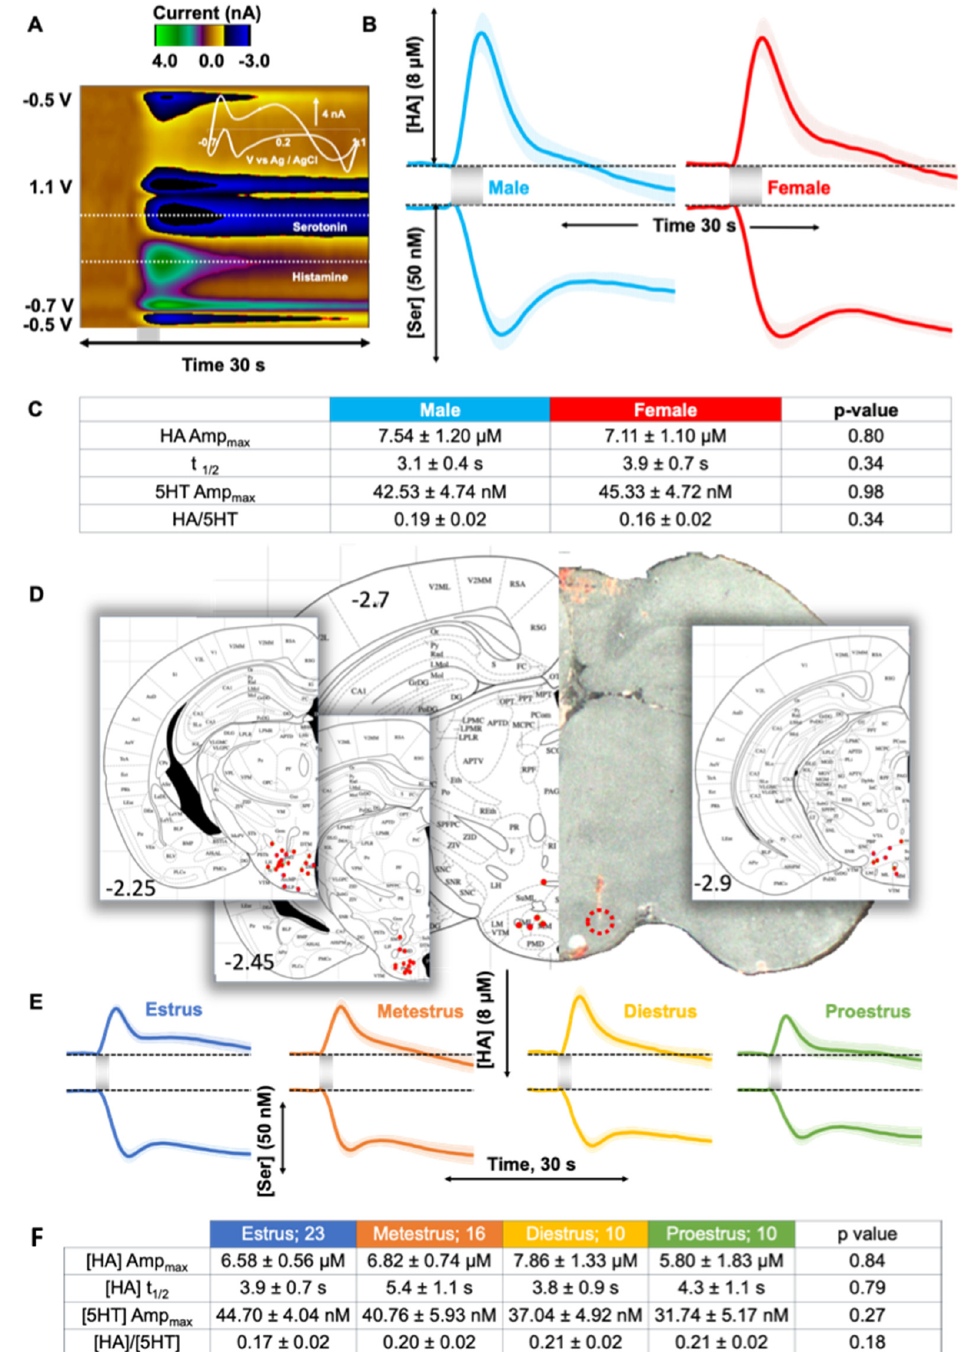
Figure 1. ( A ) Representative color plot of the mouse TMN upon MFB stimulation. Inset in the top right corner is the characteristic CV with peaks occurring around 0.2 V for histamine and 0.7 V for serotonin oxidation. The concentration vs. time traces for the release of histamine and inhibition of serotonin are shown for ( B ) male (blue) and female (red) mice. Electrical stimulation (2 s) is represented by the grey bars. ( C ) Tabulated values of metrics of experimental data in male and female mice. ( D ) Placement of the CFMs in all experiments in this paper in the lateral hypothalamus. ( E ) Evoked histamine release and serotonin inhibition for female mice in estrous ( n = 23), metestrus ( n = 16), diestrus ( n = 10), and proestrus ( n = 10) stages. The shaded grey bar represents the 2 s electrical stimulation. ( F ) Tabulated values of metrics of experimental data in female mice in different stages of the estrous cycle.